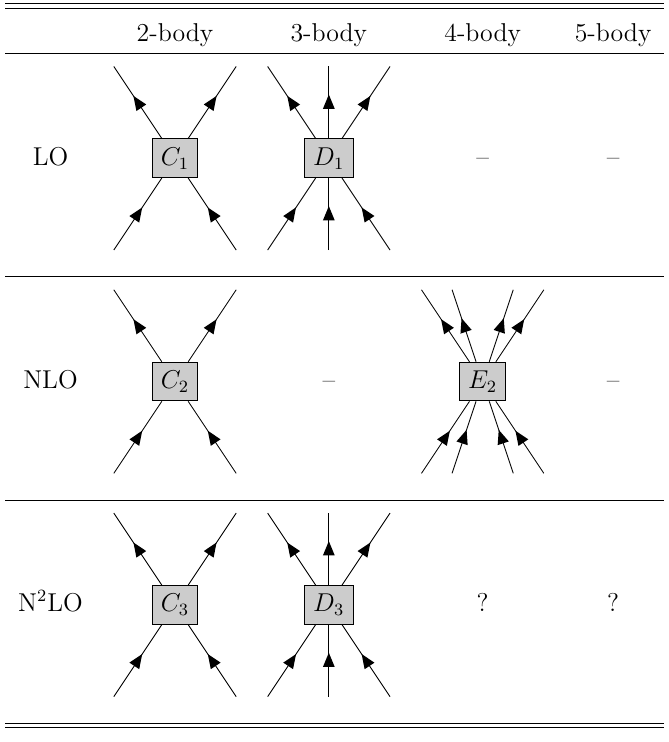
Figure 1. Diagrammatic representation of the multi baryon interaction in BEFT. The order n of each term is indicated by N n LO. The letters in each diagram stand for the corresponding